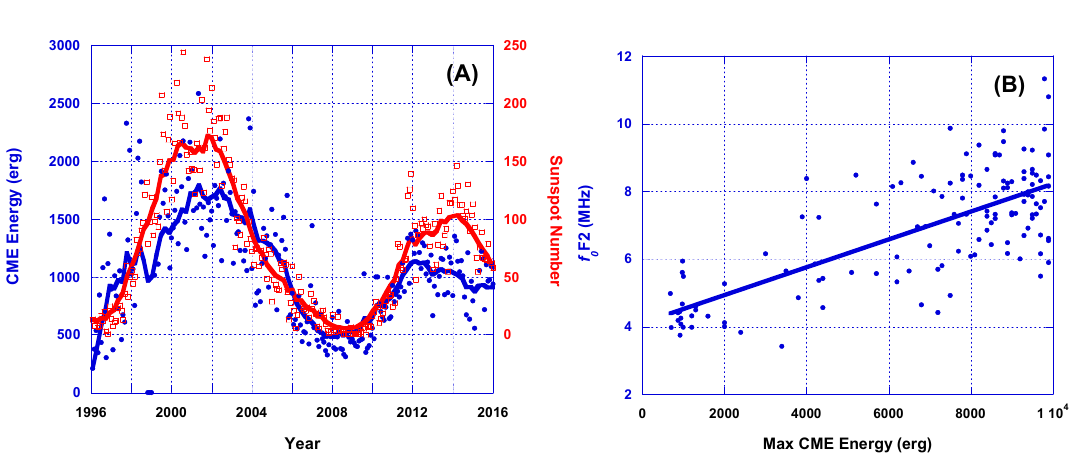
Figure 4. The time series of the monthly average values CME initial speed (Km/s) and that of the sunspot numbers (SSN) during the period 1996–2013 ( A ), and the relationship between F values and